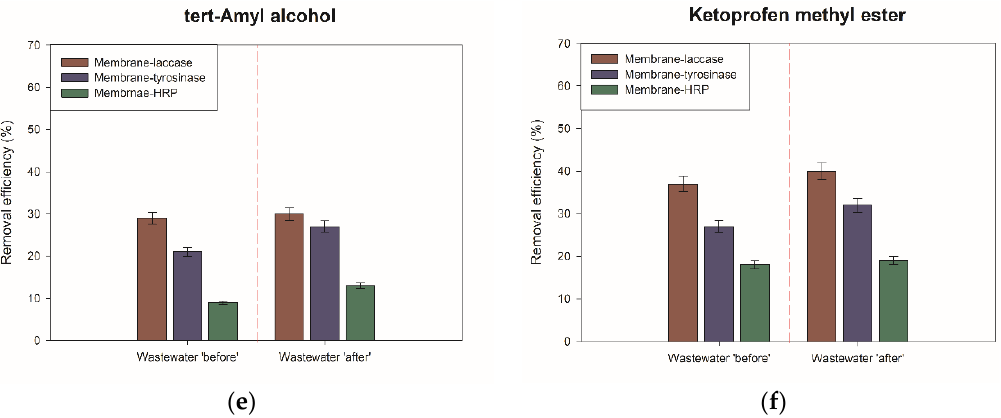
Figure 5. Removal efficiency of ( a ) hematoporphyrin, ( b ) (2,4-dichlorophenoxy)acetic acid (2,4-D), ( c ) 17 α -ethynylestradiol (EE2), ( d ) tetracycline, ( e ) tert-amyl alcohol and ( f ) ketoprofen methyl ester after treatment by various biocatalytic membranes. All values are presented with a mean value of 3 experiments ± standard deviation.